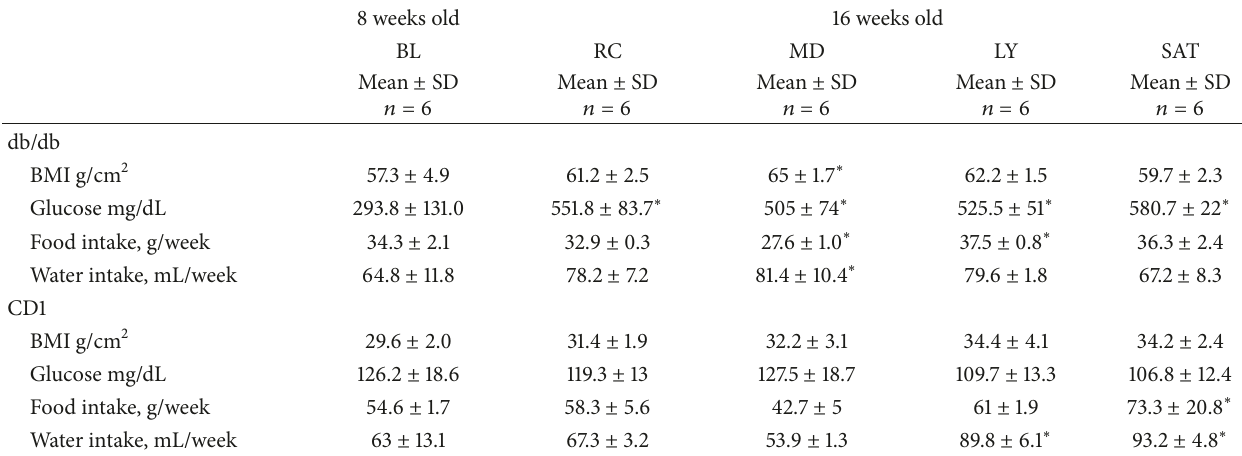
Table 2: Effect of supplementation with EPA and DHA extracted from microalgae on body mass index, blood glucose, food, and water consumption in db/db and CD1